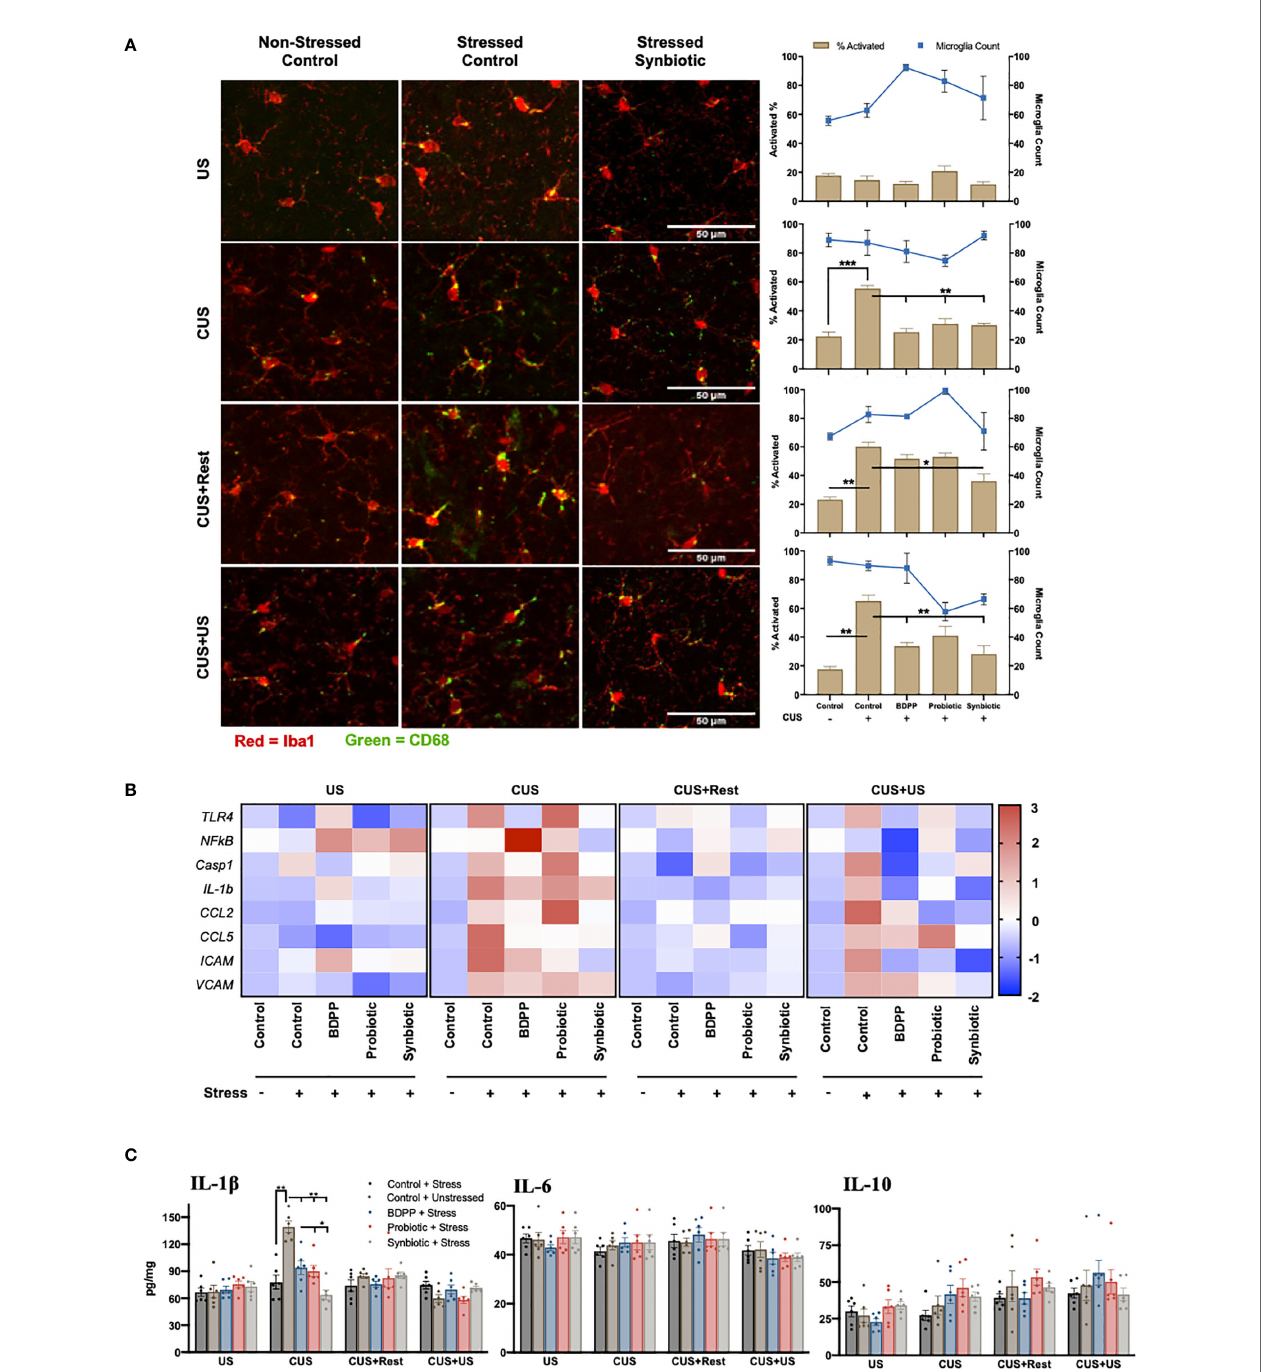
FIGURE 2 | Dissimilarity between recurrent stress behavioral phenotype with neuroin fl ammatory correlates. The behavioral phenotype was aligned with microglia activation in the prefrontal cortex as determined by (A) immunohistochemical analysis of Iba1 (red) and CD68 (green) for area and activation, respectively ( n = 6 +/- SEM). Quanti fi cation was determined as the percentage of surface area covered by CD68 vs. Iba1 (brown bars, left axis) and displayed with the microglia count per frame (blue line, right axis) with signi fi cance determined with one-way ANOVA and Tukey ’ s post-hoc analysis. (B) Immunological markers of microglia activation were validated with region-speci fi c gene expression ( n = 6, different mice than used for the IHC) and represented as the ratio of stressed vs. non-stressed for the respective group normalized with the z-score across all timepoints for a single gene. A positive z-score is represented with red and a negative z-score with blue. Absolute quanti fi cation of key cytokine expression (C) of IL-1 b (left), IL-6 (middle) and IL-10 (right). Statistical markers are delineated by *p < 0.05, **p < 0.01 and ***p <